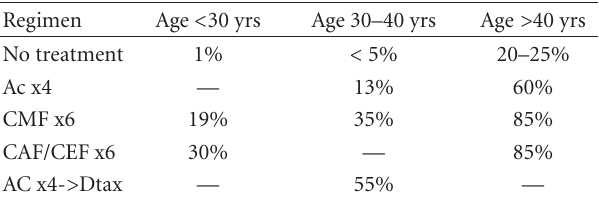
Table 2: Rate of chemotherapy-induced amenorrhea, according to regimen and